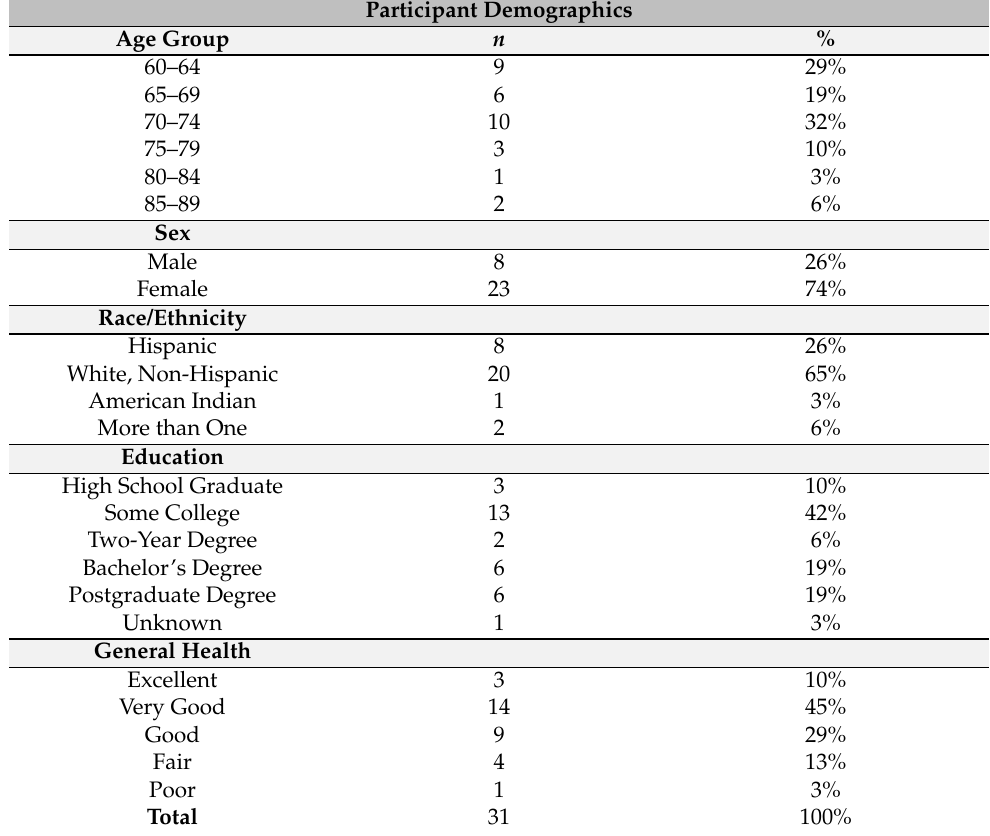
Table 2. Demographics characteristics of participants ( n = 31) in interviews and focus groups of rural cancer